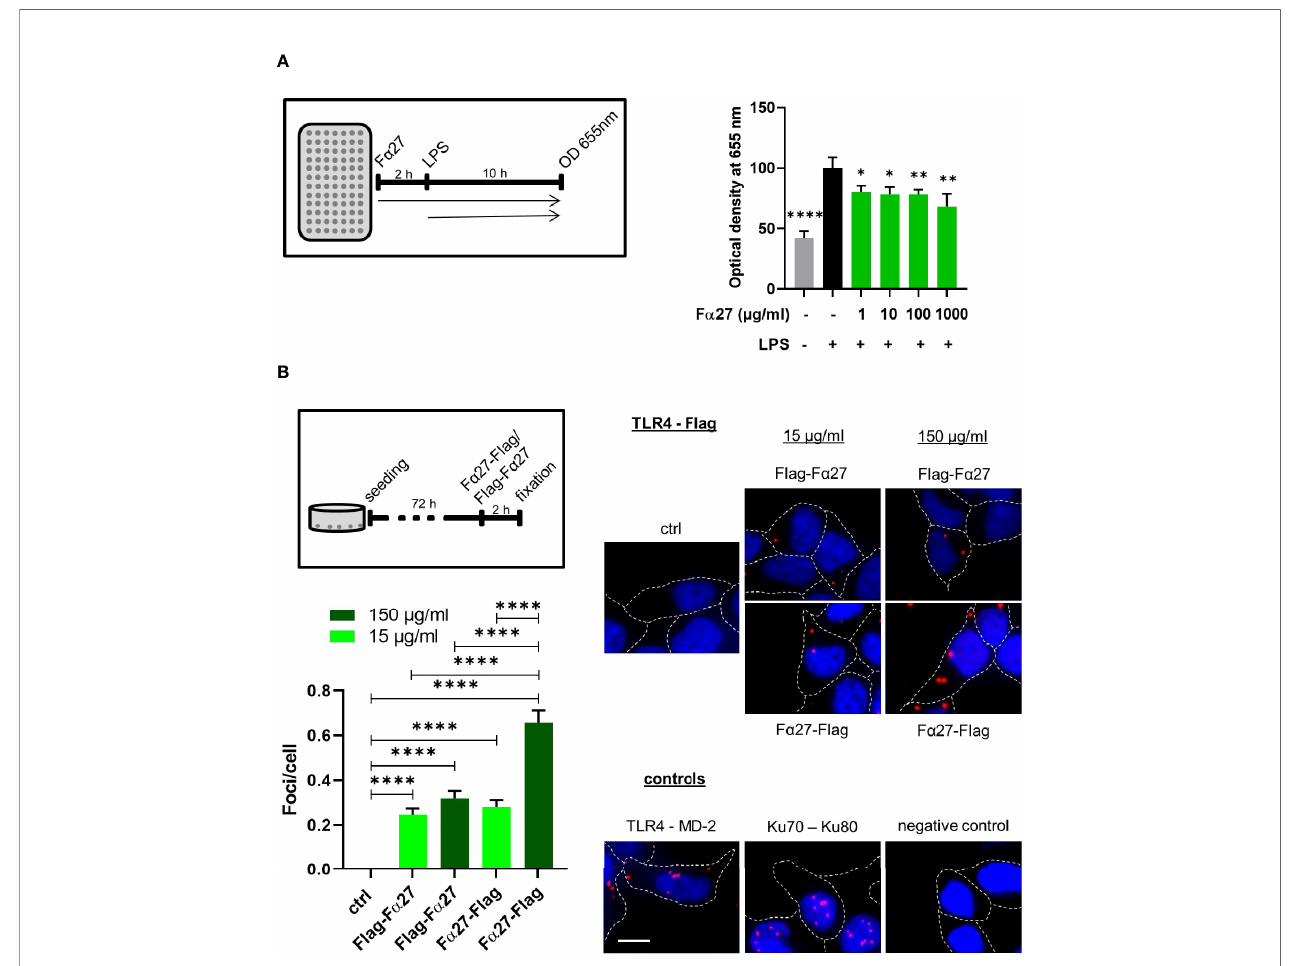
FIGURE 7 | F a 27 binds TLR4 and reduces LPS stimulation. (A) F a 27 inhibits TLR4 activation by LPS. Scheme of experimental analysis of TLR4 signaling and results obtained in HEK-Blue hTLR4 cells pre-treated for 2 h with different concentrations of F a 27 followed by additional treatment with 10 ng/ml LPS for 10 h. TLR4 stimulation led to a release of secreted embryonic alkaline phosphatase (SEAP) detected at OD 655 nm. LPS treatment increased SEAP release which was reduced by F a 27 pre-treatment. Mean OD values of LPS-treated controls without peptide were set to 100% in each experiment. Data (n=12 obtained in two experiments) are shown as mean +SEM and statistics were calculated relative to LPS stimulation without peptide (*p < 0.05; **p < 0.01; ****p < 0.0001). (B) TLR4 and F a 27 interaction. HEK-Blue hTLR4 cells were seeded 72 h before the experiment and treated for 2 h with N-terminally tagged Flag-F a 27, C-terminally tagged F a 27-Flag or water (ctrl). PLA analysis showed an interaction between both tagged F a 27 peptides and the TLR4. Two positive controls are shown: PLA for TLR4 and its binding partner MD-2 on the cellular surface and for Ku70-Ku80 complexes in the nucleus. The negative control was done with PLA substrates but without antibodies. Margins of cells are marked by white stippled lines and the scale bar indicates 10 µM (n=187-425 from two independent experiments each; mean +SEM; ****p < 0.0001). See also Figure S6